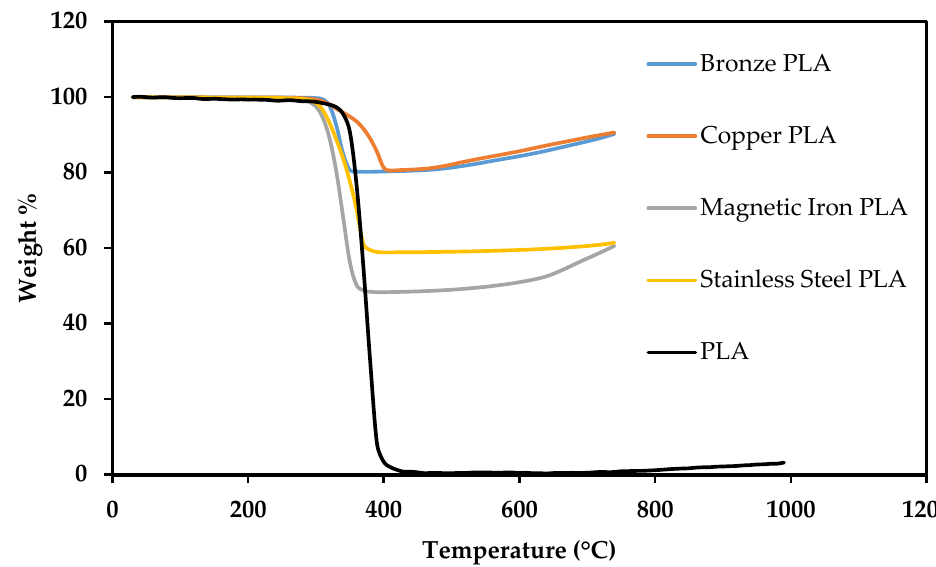
Figure 4. TGA results of materials conducted in air.